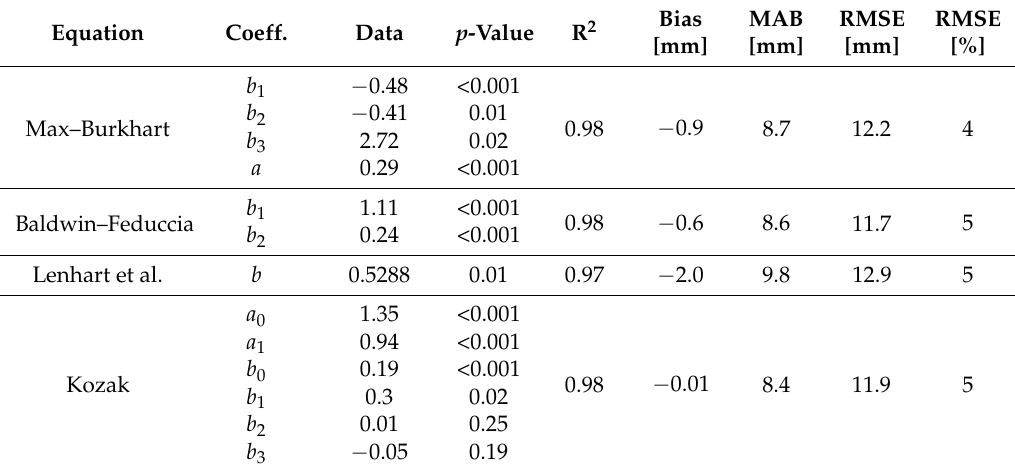
Table 5. Taper models developed from ground-based measurements. Equation